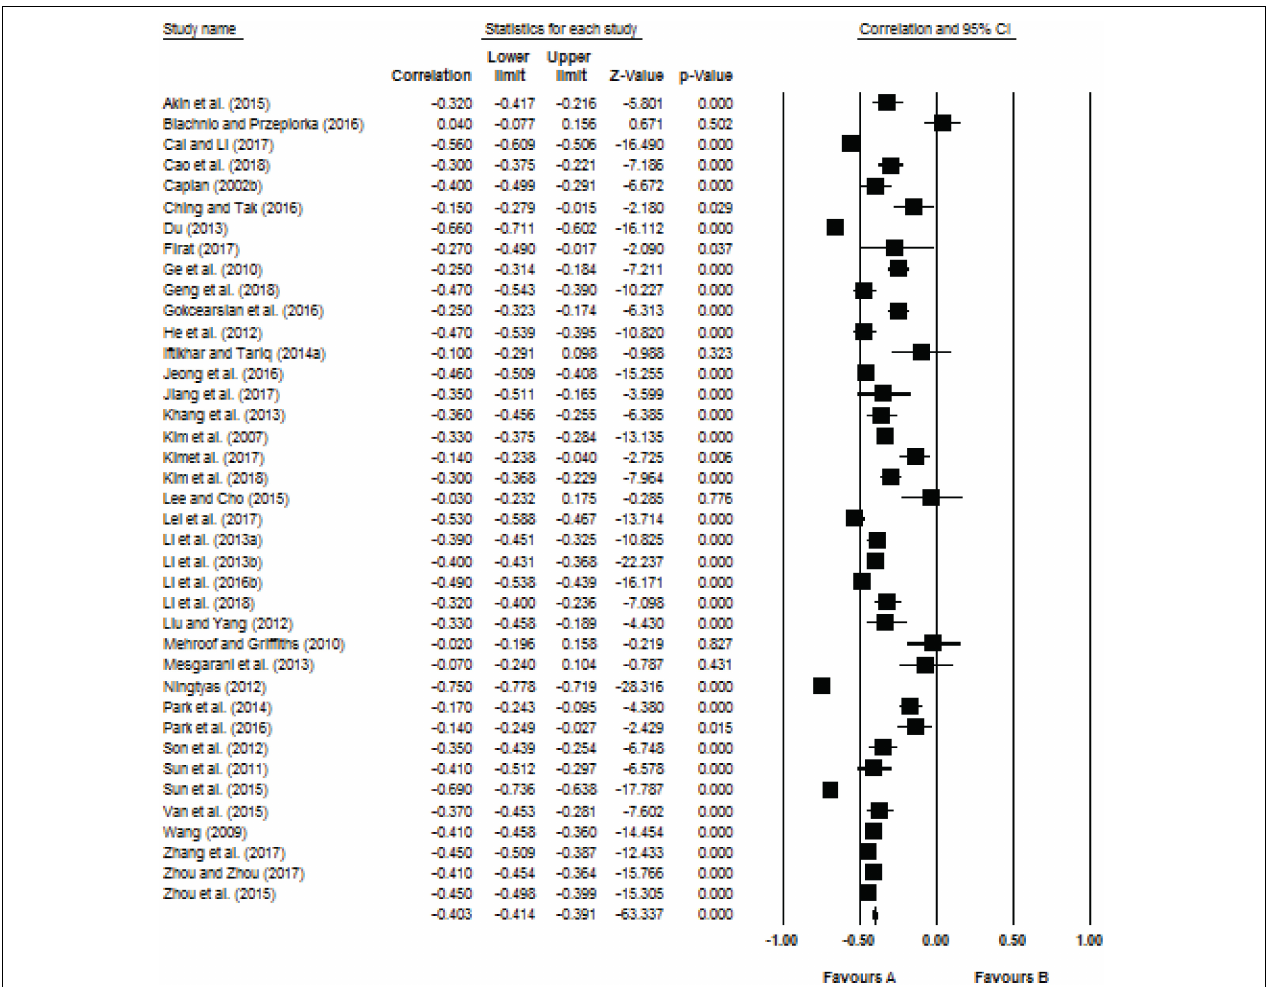
FIGURE 3 | Forest plot for the relationship between restraint indicator and Internet